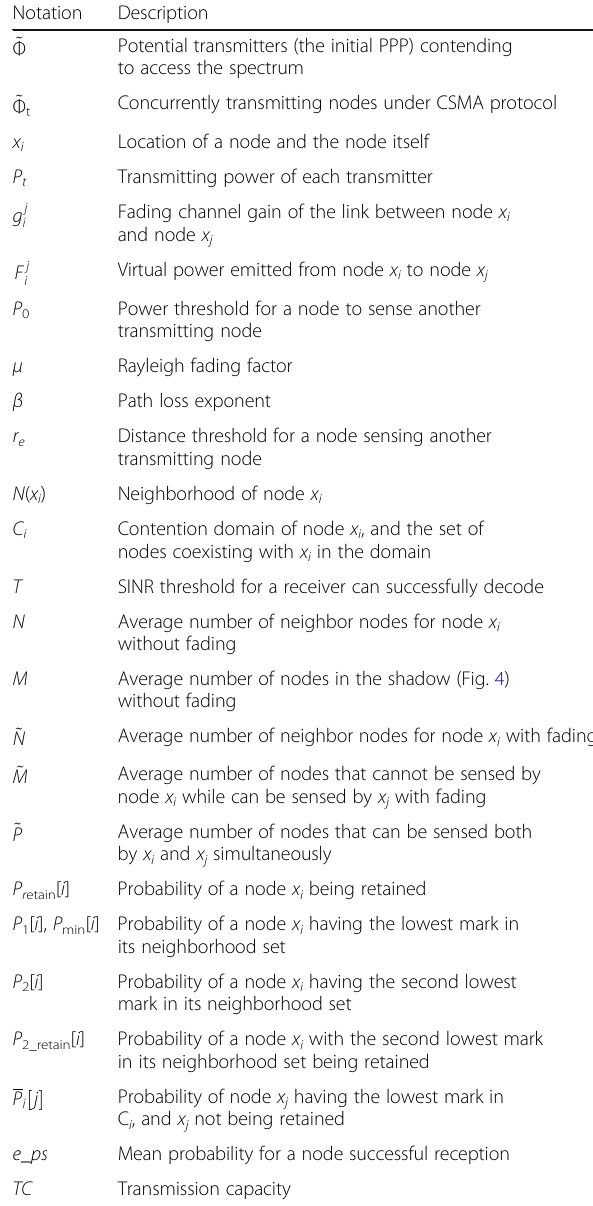
Table 1 List of key